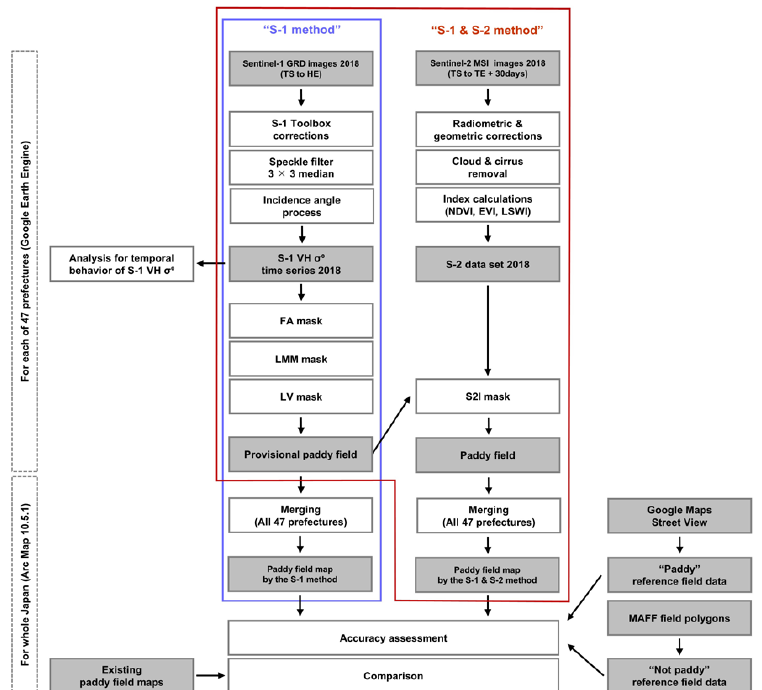
Figure 4. Flow chart of the two paddy field mapping methods, the conventional method S-1 method and our newly proposed S-1 & S-2 method, and their validation by comparisons with reference fields and existing maps.